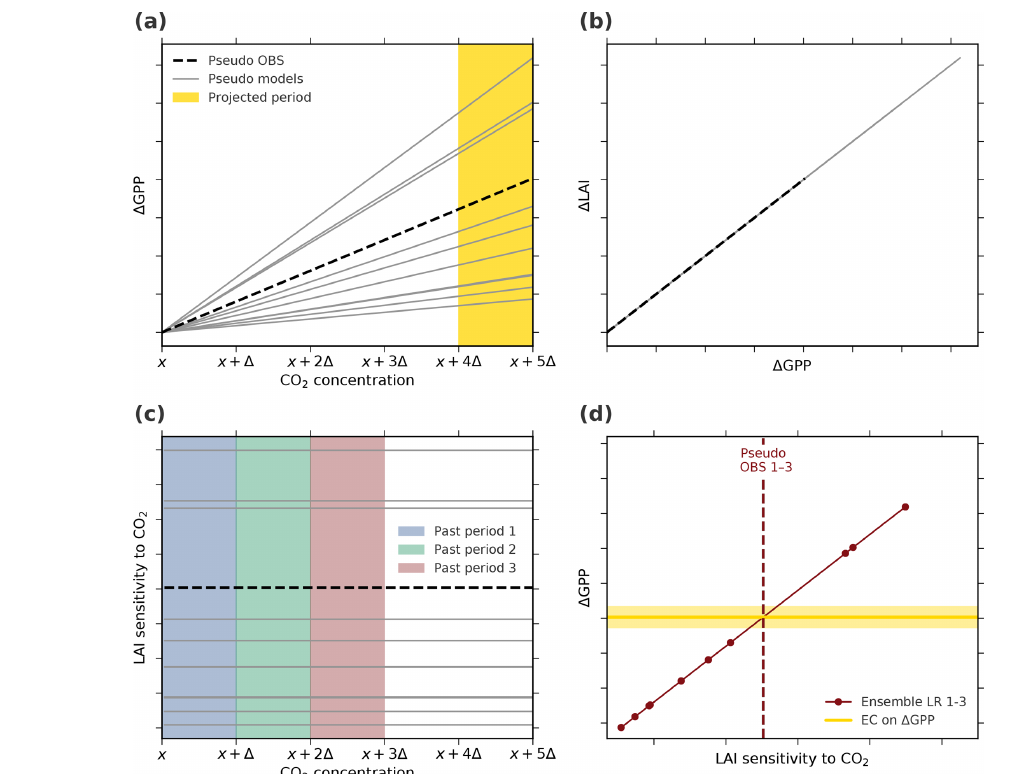
Figure A5. Thought experiment to examine the applicability of the EC analysis assuming an idealized linear–linear behavior of the system (Case 1, Table A1). (a) Changes in GPP relate linearly to changes in CO 2 concentration. The yellow band marks the projection period of interest, i.e., the period of CO 2 concentration from x + 4 (cid:49) to x + 5 (cid:49) . (b) Changes in LAI relate linearly to changes in GPP. The param- eterization in the linear functions for pseudo observations (dashed black line) as well as models (solid gray lines) is determined randomly for each model. (c) The diagnostic variable, LAI sensitivity to CO 2 , remains constant with increasing CO 2 as a consequence of the overall linear characteristics of the system. The colored bands indicate three “past” periods from x to x + (cid:49) (blue), x + (cid:49) to x + 2 (cid:49) (green), and x + 2 (cid:49) to x + 3 (cid:49) (red). (d) Linear relationships among the pseudo model ensembles (Ensemble LR 1–3 on top of each other, red) between LAI sensitivity to CO 2 of the three past periods and (cid:49) GPP from the projected period. Red dots mark different models and the dashed line represents associated pseudo observations for all three historical periods. The solid yellow line depicts the constant EC on projected (cid:49) GPP irrespective of the past